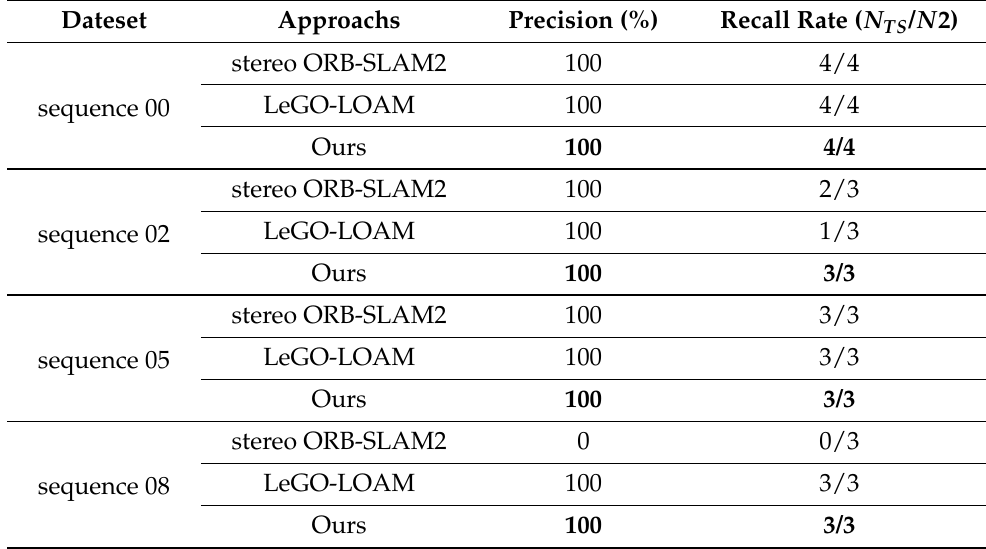
Table 5. The loop closure precision and recall comparison with existing methods. The N TS in Recall Rate represents the number of detected loop closure, and N 2 is the number of all existed loop closure segments. Best results are highlighted in